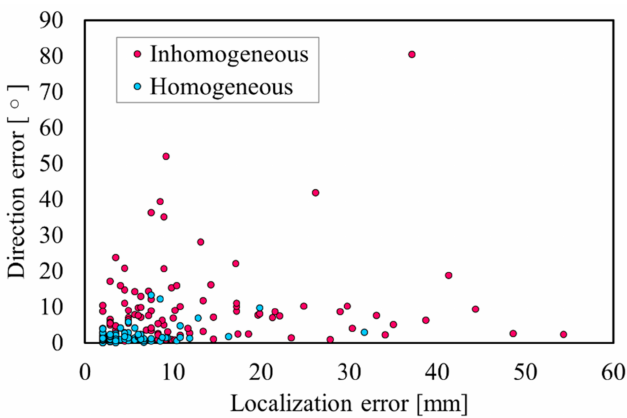
Figure 5. Relationship between LE and DE for each model with SNR = ∞ .